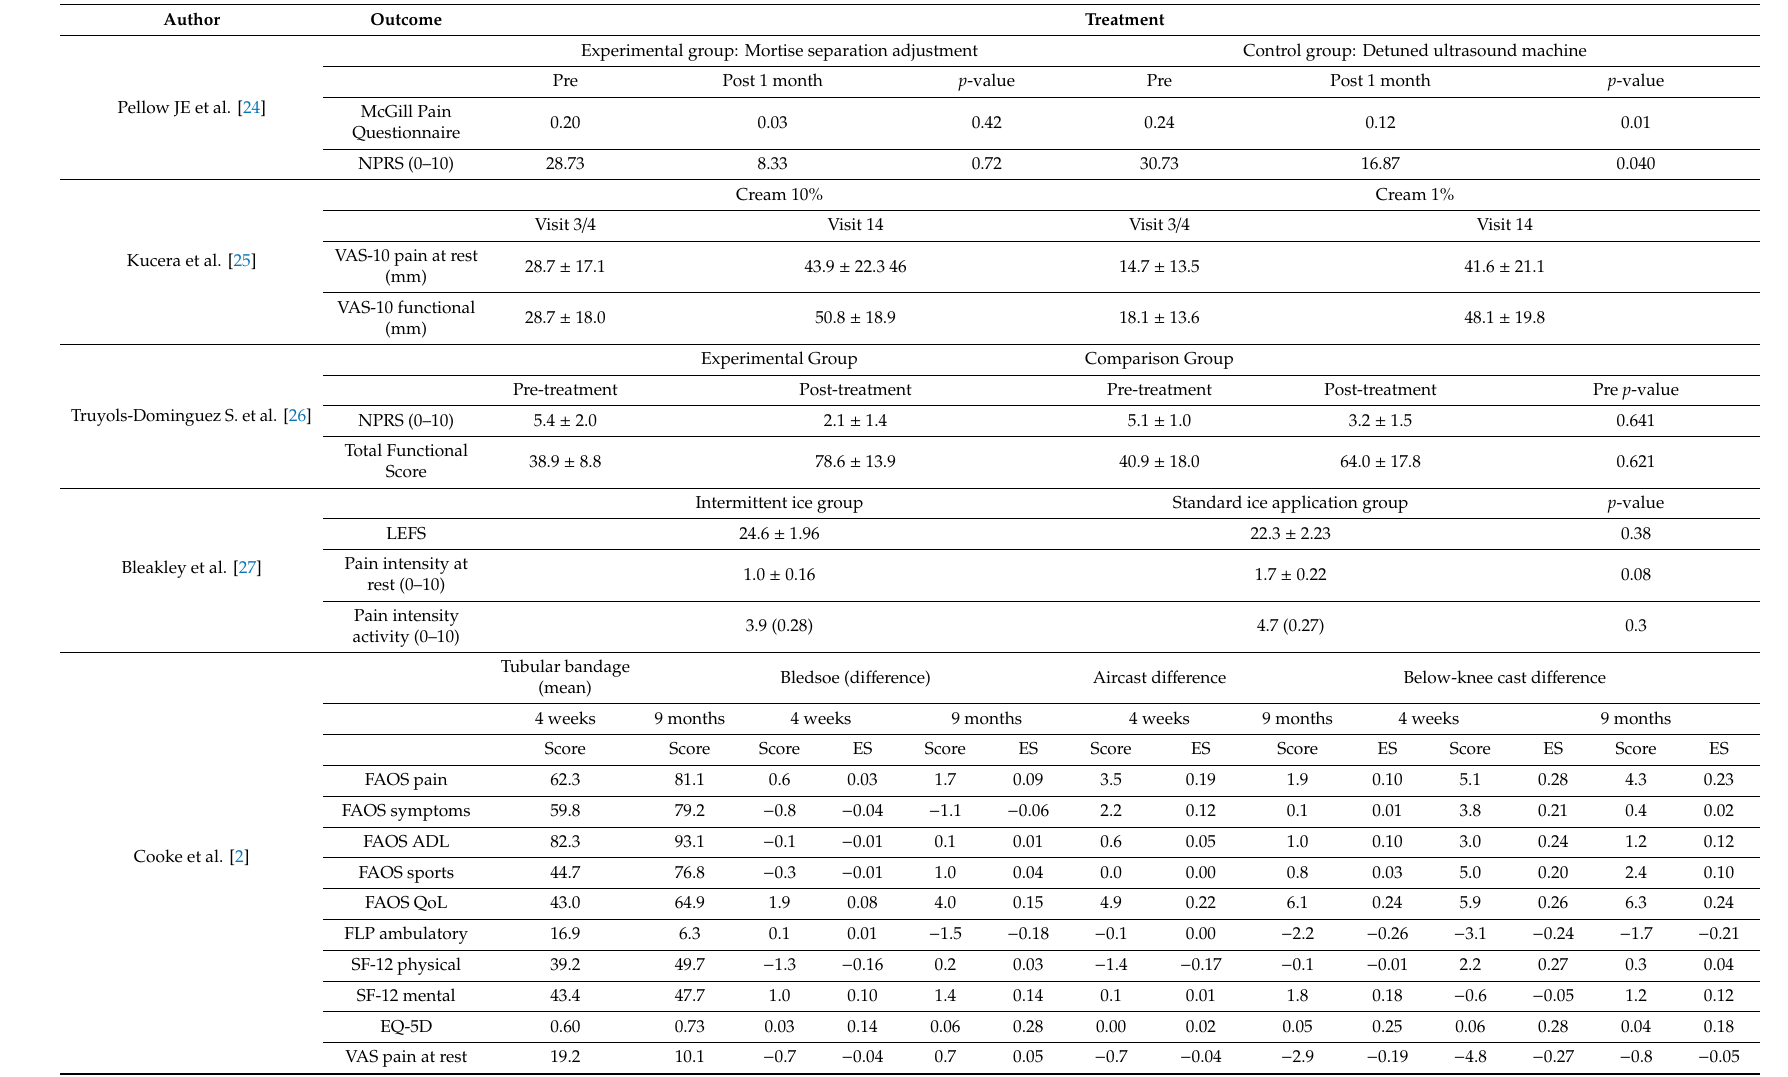
Table 2. Reported outcomes for pain relief and recovery of functional